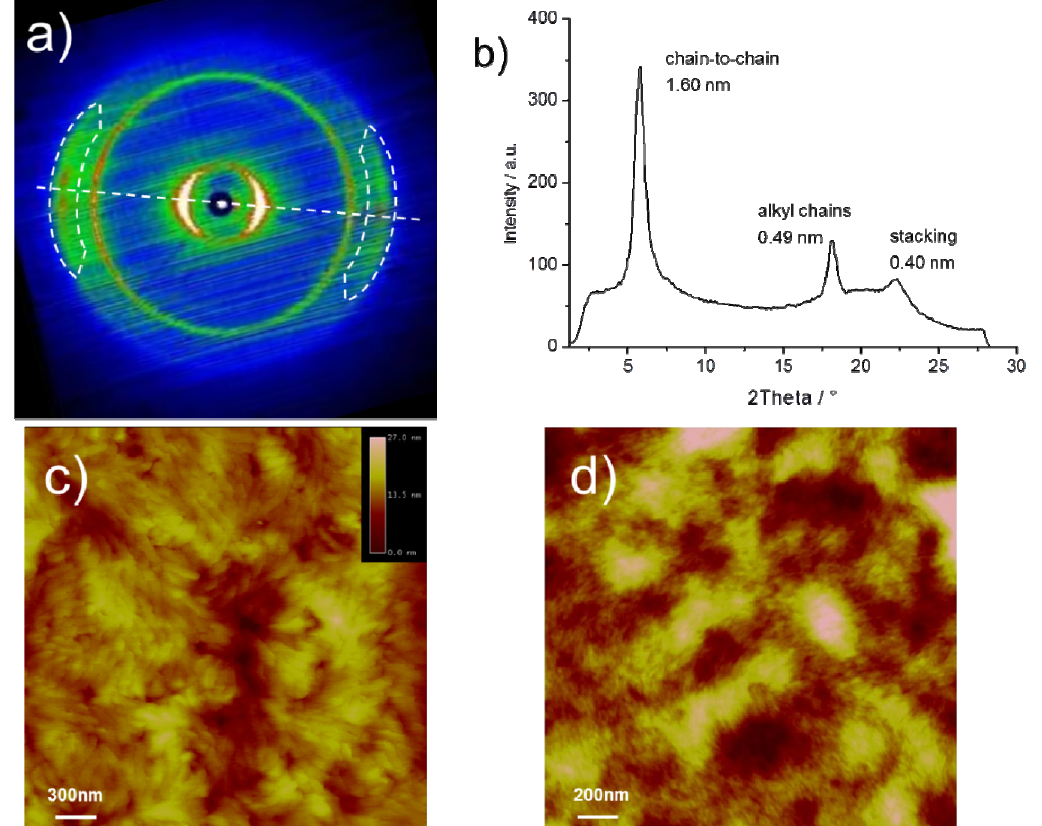
Figure 3. ( a ) Two-dimensional wide-angle X-ray scattering (2DWAXS) pattern (dashed line indicates the equatorial integration; reflections attributed to polymer stacking are marked by dashed circles) of CDT-BTZ-C14,10 ; ( b ) equatorial integration with characteristic d-spacings; ( c ) tapping mode AFM height image of thin film; ( d ) tapping mode AFM height image of CDT-BTZ-C16